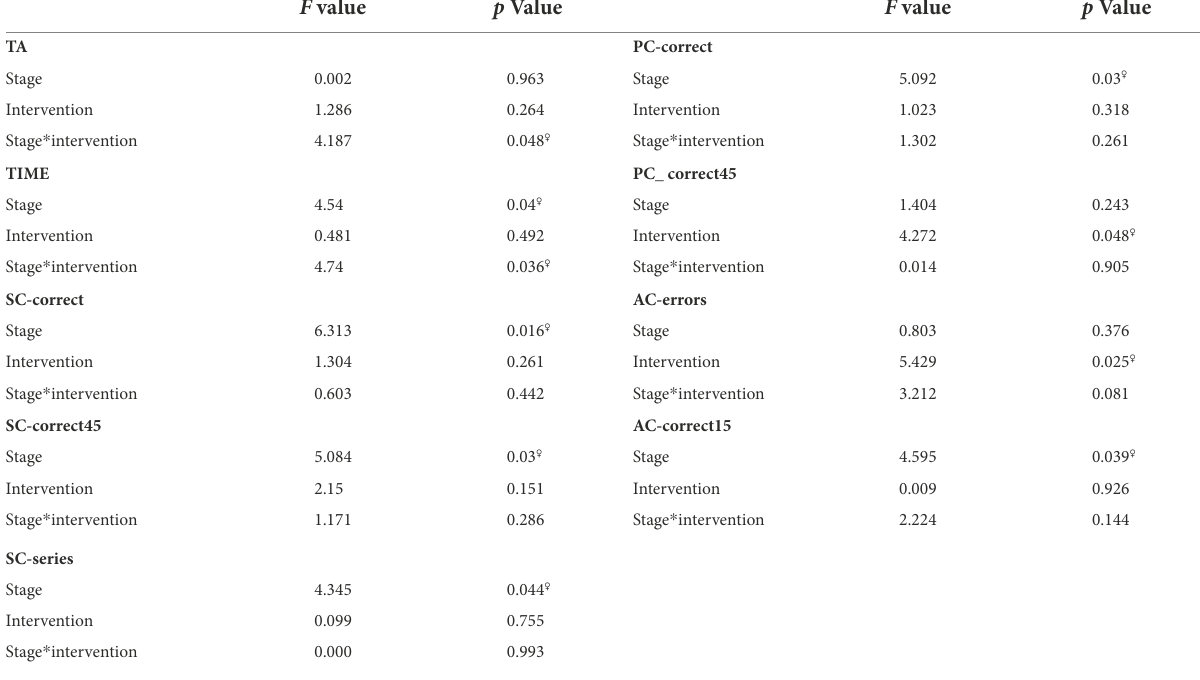
TABLE 1 Cognitive tasks: results of the general linear model (GLM) related to cognitive performance. F value p Value F value p